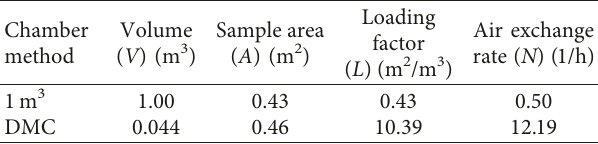
Table 2: Differences between the experimental settings of the 1m 3 and the DMC chamber